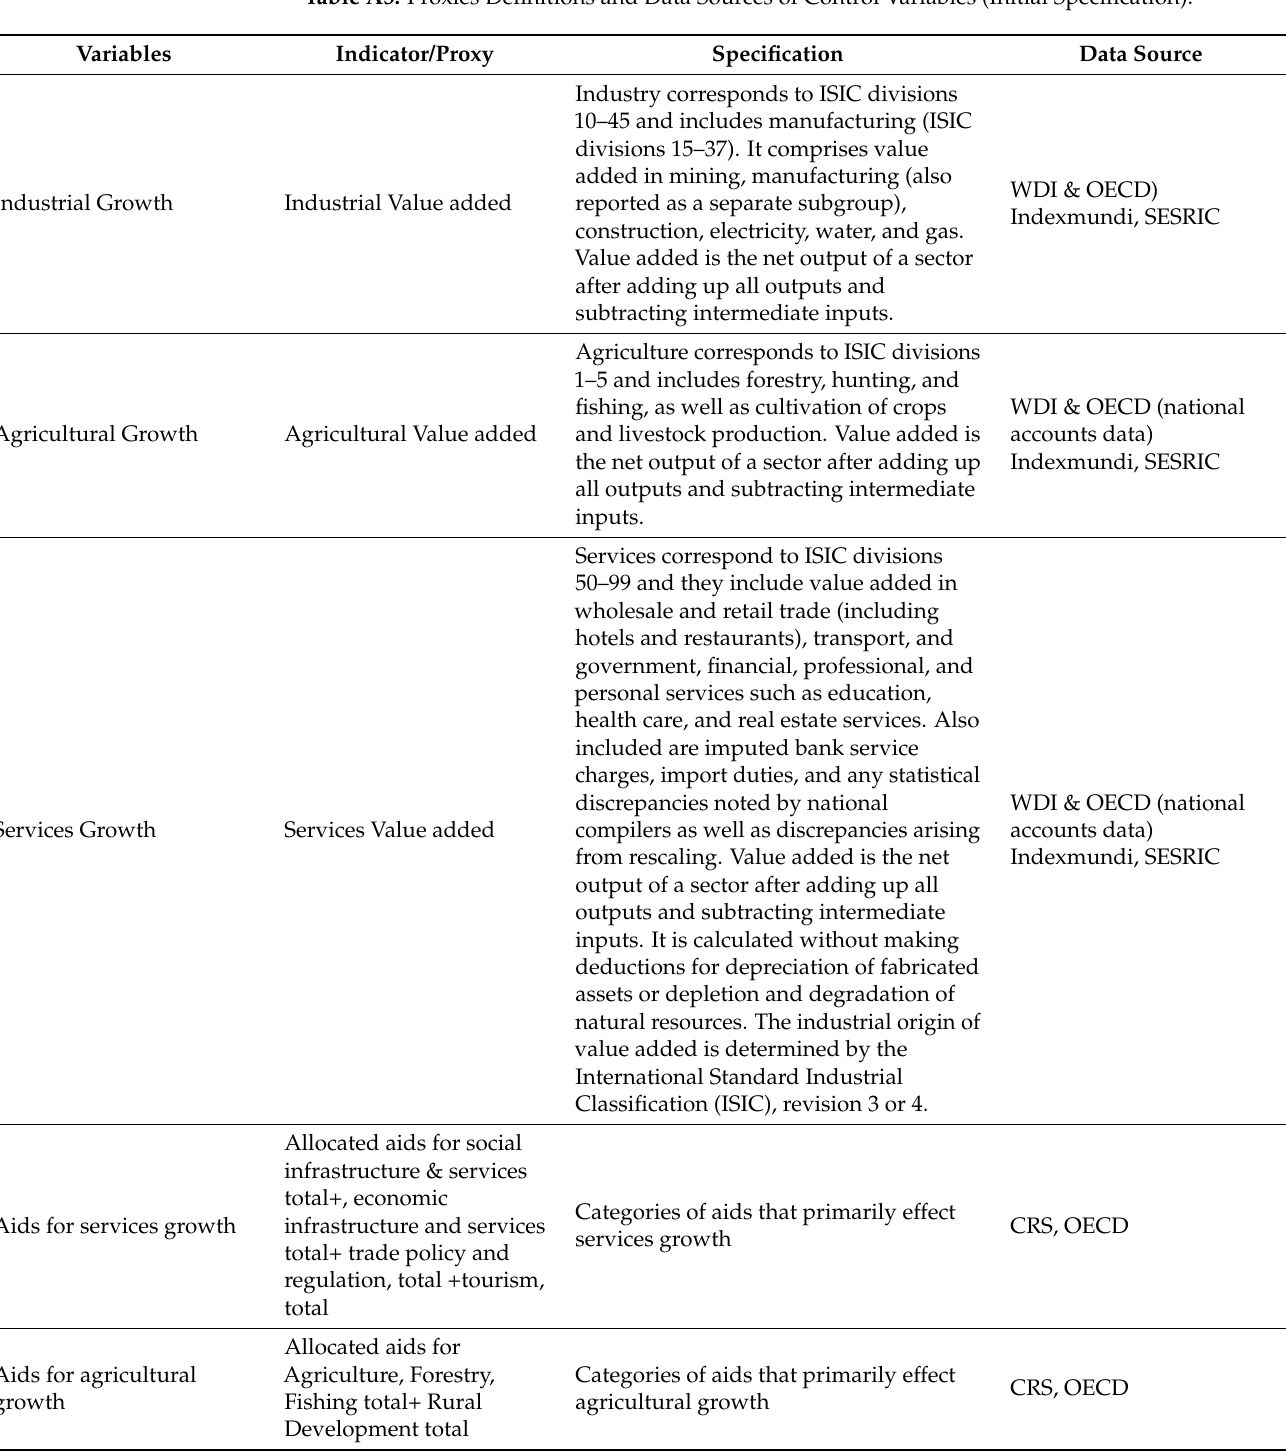
Table A5. Proxies Definitions and Data Sources of Control Variables (Initial